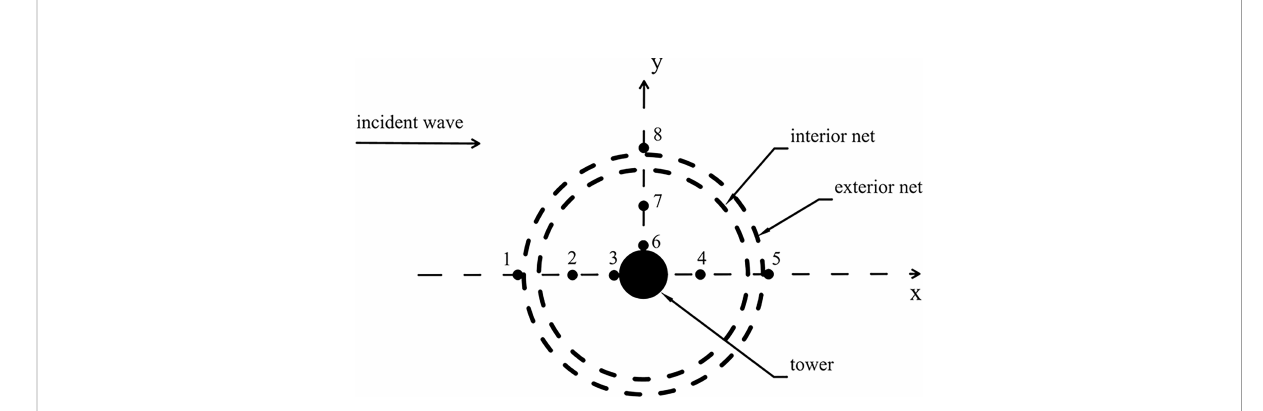
FIGURE 9 Layout of measurement sites for investigating wave elevation with different